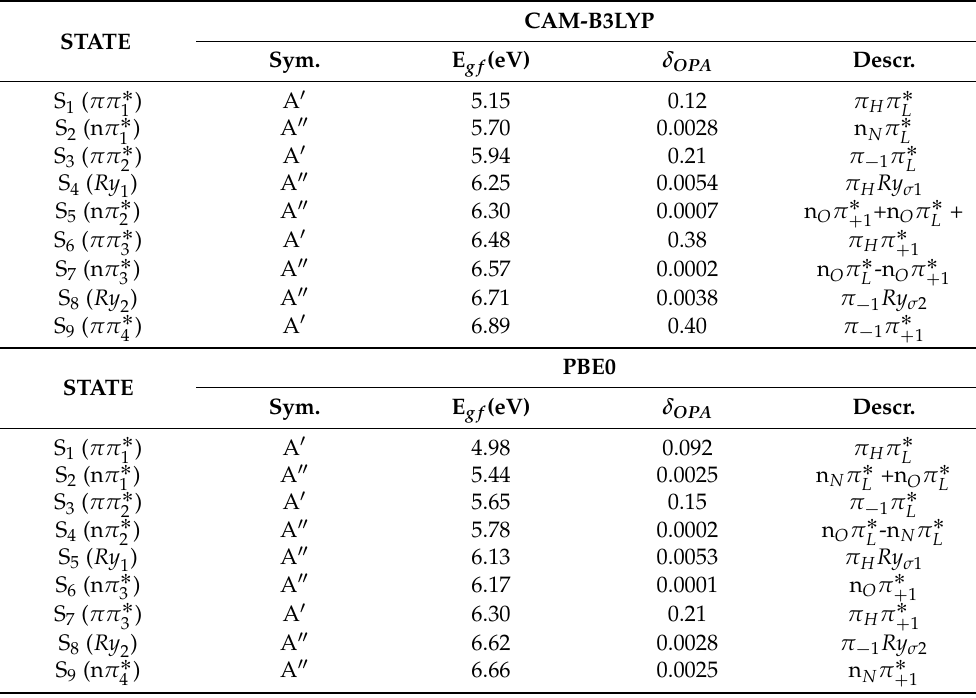
Table 1. Symmetry, vertical excitation energies E gf (eV), and oscillator strengths ( δ OPA ) of the first nine excited states for cytosine ( C s symmetry point group), calculated by CAM-B3LYP and PBE0, with the 6-311+G(d,p) basis sets in water (PCM). CAM-B3LYP STATE Sym. E gf (eV) δ OPA Descr. S 1 ( ππ ˚ 1